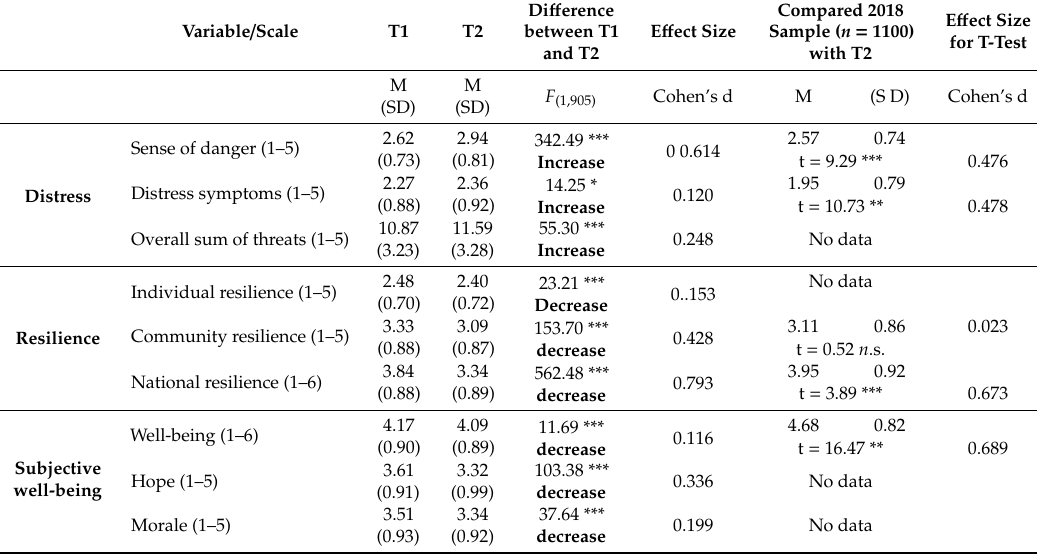
Table 3. General Linear Model—two repeated measures of distress symptoms, resilience, and subjective well-being—di ff erences, and e ff ect size ( n =